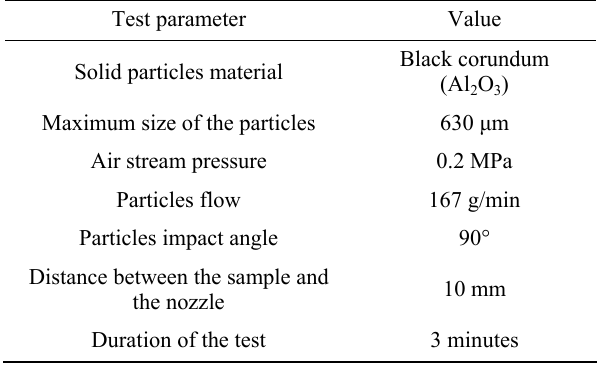
Fig. 1 Schematic of erosive wear testing. Table 3 Parameters used in the erosive wear